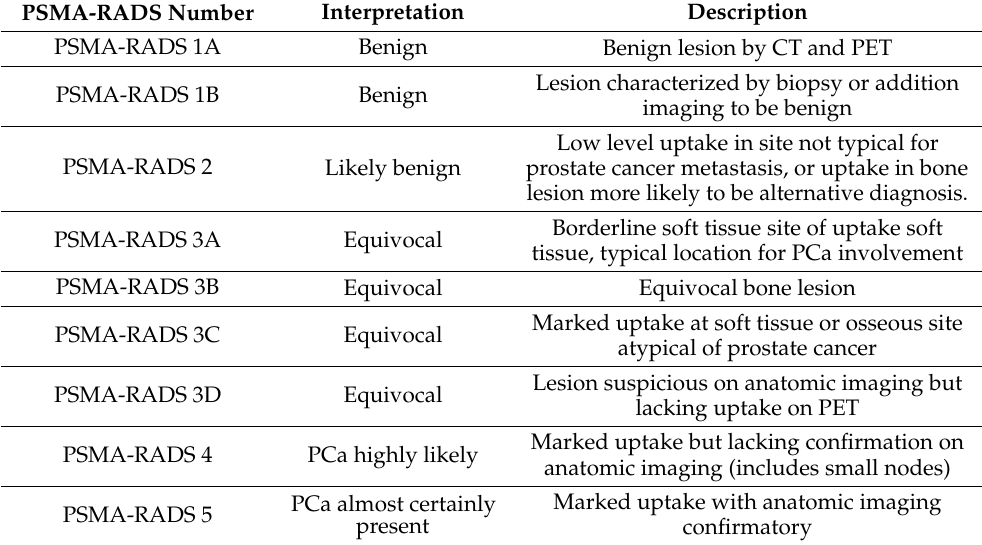
Table 7. PSMA-RADS structured reporting system for PSMA-targeted PET-CT for prostate cancer (PCa) *. PSMA-RADS Number